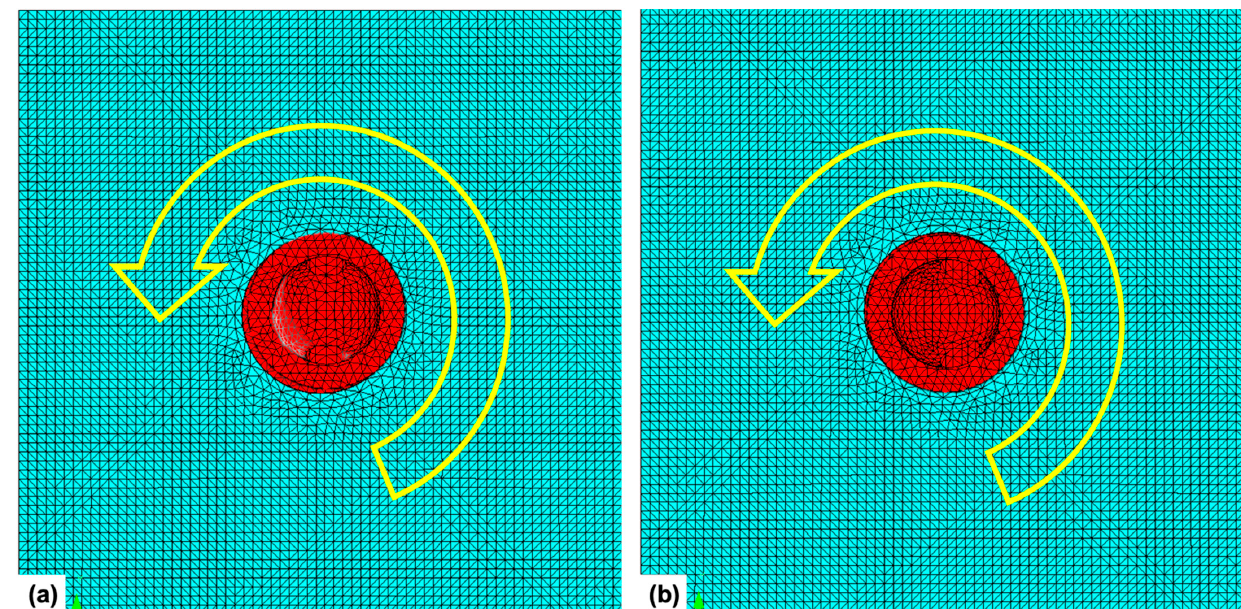
Figure 2. Direction of rotation applied to the miniscrew model: ( a ) on the top view of the miniscrew head part in the centric hole group, counterclockwise rotation was applied with the long axis of the miniscrew as a center of rotation; ( b ) same rotational direction (counterclockwise rotation) was applied to a miniscrew in the eccentric hole group.